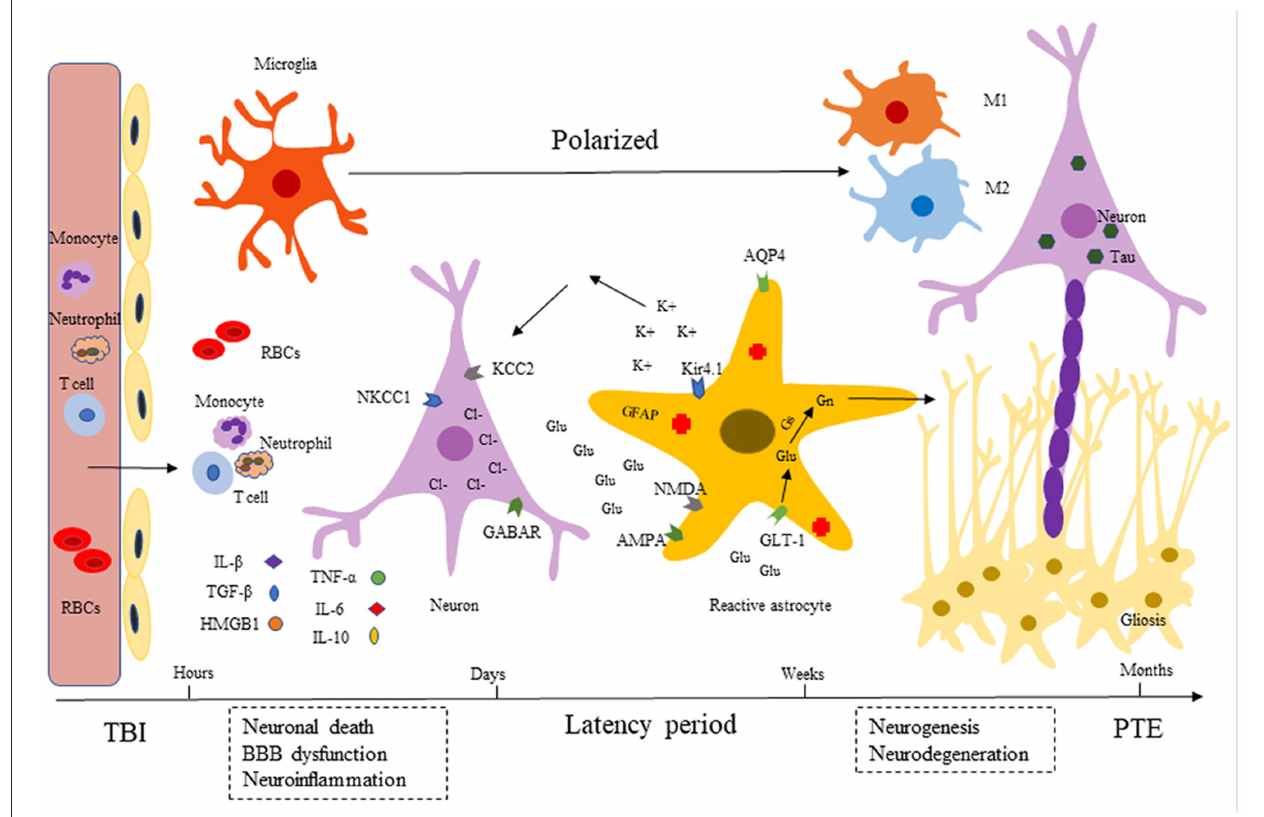
FIGURE 1 | Development of post-traumatic epilepsy (PTE). After TBI, there are a series of immune inflammatory reactions including BBB dysfunction (endothelial cells destruction), microglia and astrocytes activation, neuroinflammatory factors release (IL-1 β , HMGB1 TGF- β , TNF- α , etc.). Released inflammatory cytokines can recruit neutrophils and monocytes into injured tissues, expanding the inflammatory cascade. Over time (months to years), injury-induced neurogenesis and neuroplasticity help repair and regeneration, persistent chronic neuroinflammation promotes neurodegeneration (Tau accumulation). These pathological processes lead to excessive excitement of neurons, which eventually causes repeated